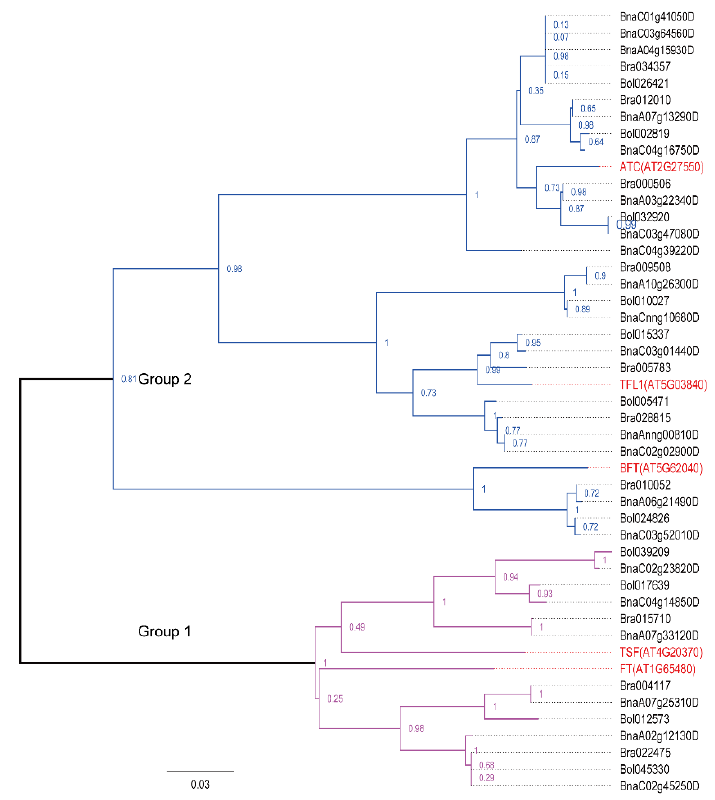
Figure 2. Phylogeny of PEBP family proteins in A. thaliana , B. napus , B. rapa , and B. oleracea . The